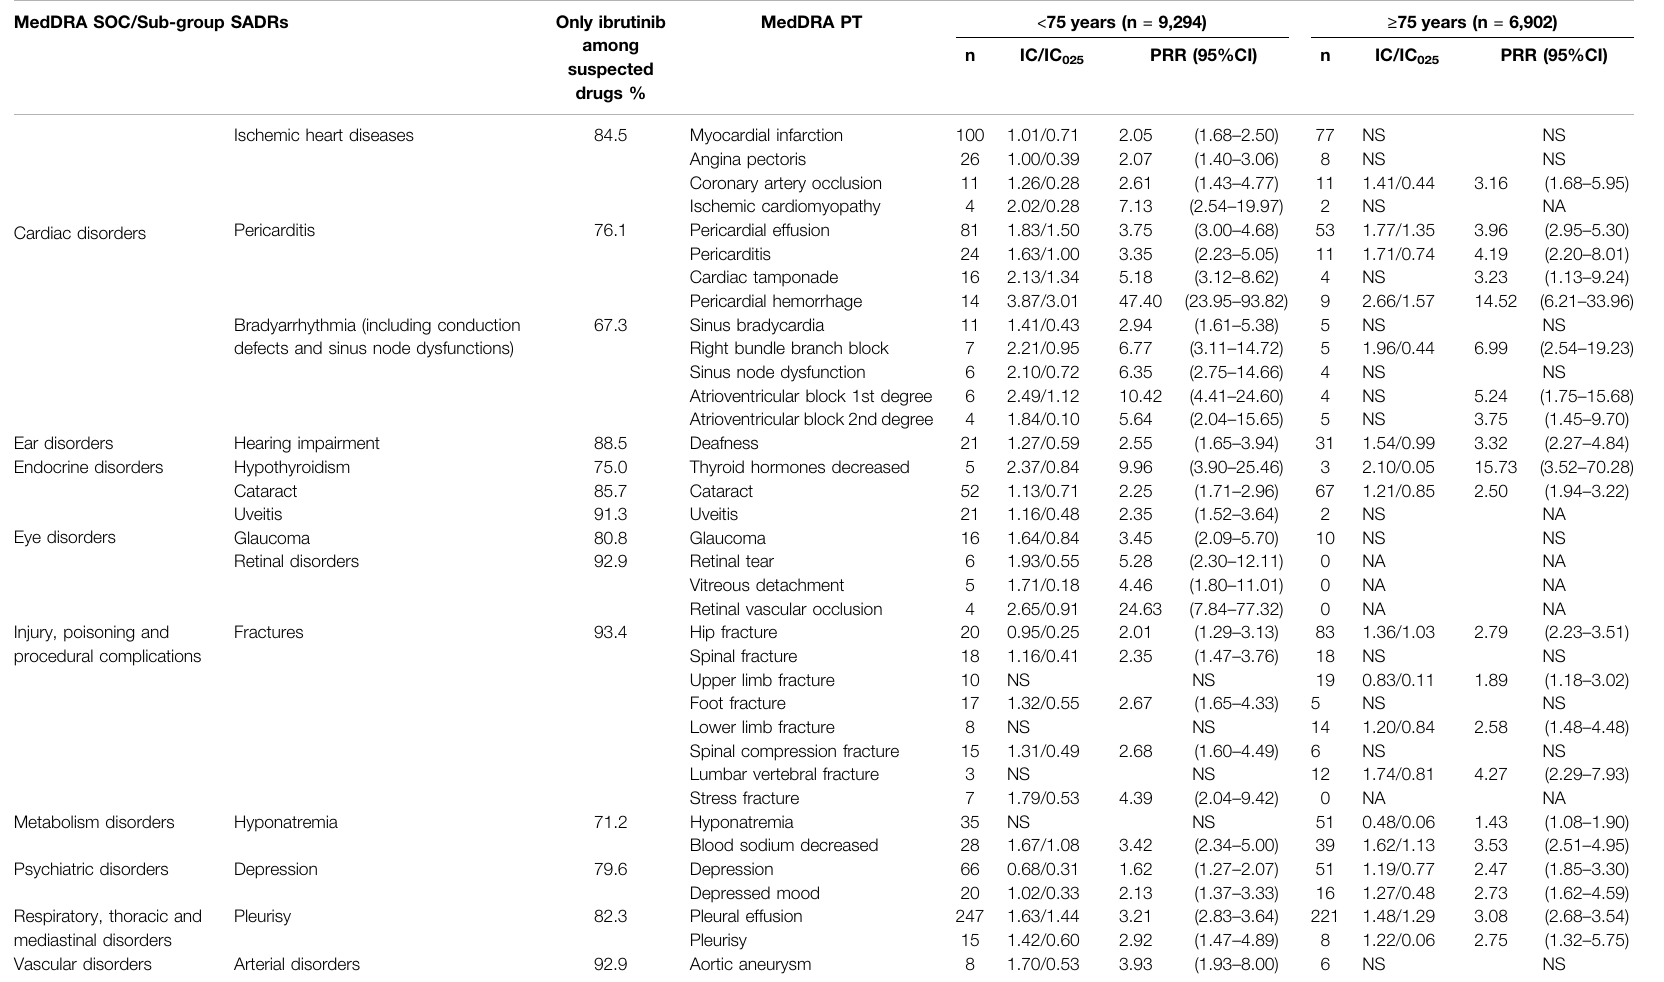
TABLE 3 | Potential safety signals identi fi ed in VigiBase, according to age groups. MedDRA SOC/Sub-group